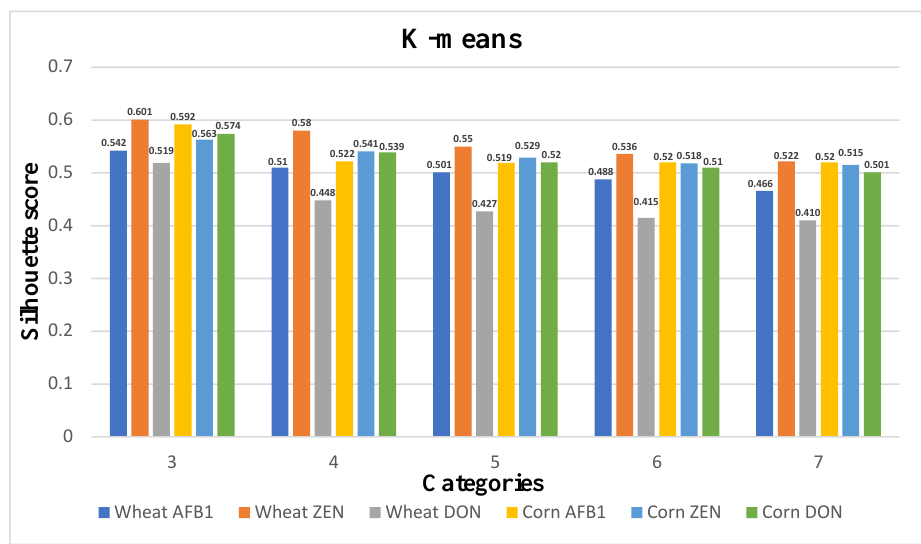
Figure 7. K-means; 5 types of clustering category profile coefficients. Figure 8 plots the clustering results of K-medoids for wheat and maize with their corresponding three toxins. Compared with K-means++ and K-means, the contour coef- ficients of each cluster are generally lower than the results of the above two algorithms, and the contour coefficients of three clusters are still the maximum.